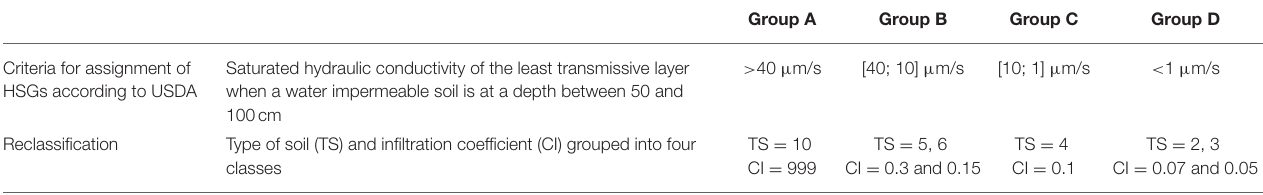
TABLE 2 | Construction of HSGs input data.